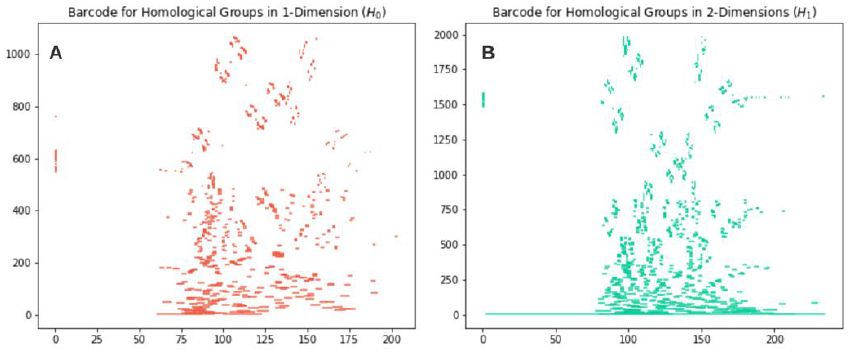
Figure 6. Corresponding bar codes for 0 and 1- dimensional homological groups ( A , B ) of Figure 4B. Displayed on the x axis are the filtrations sublevels (since it is an 8-bit image there are 256 sublevels available). The y axis shows a count of structures per sublevel in the form of bar codes. Each barcode starts and finishes at the birth and dead sublevel value for the structure it represents.